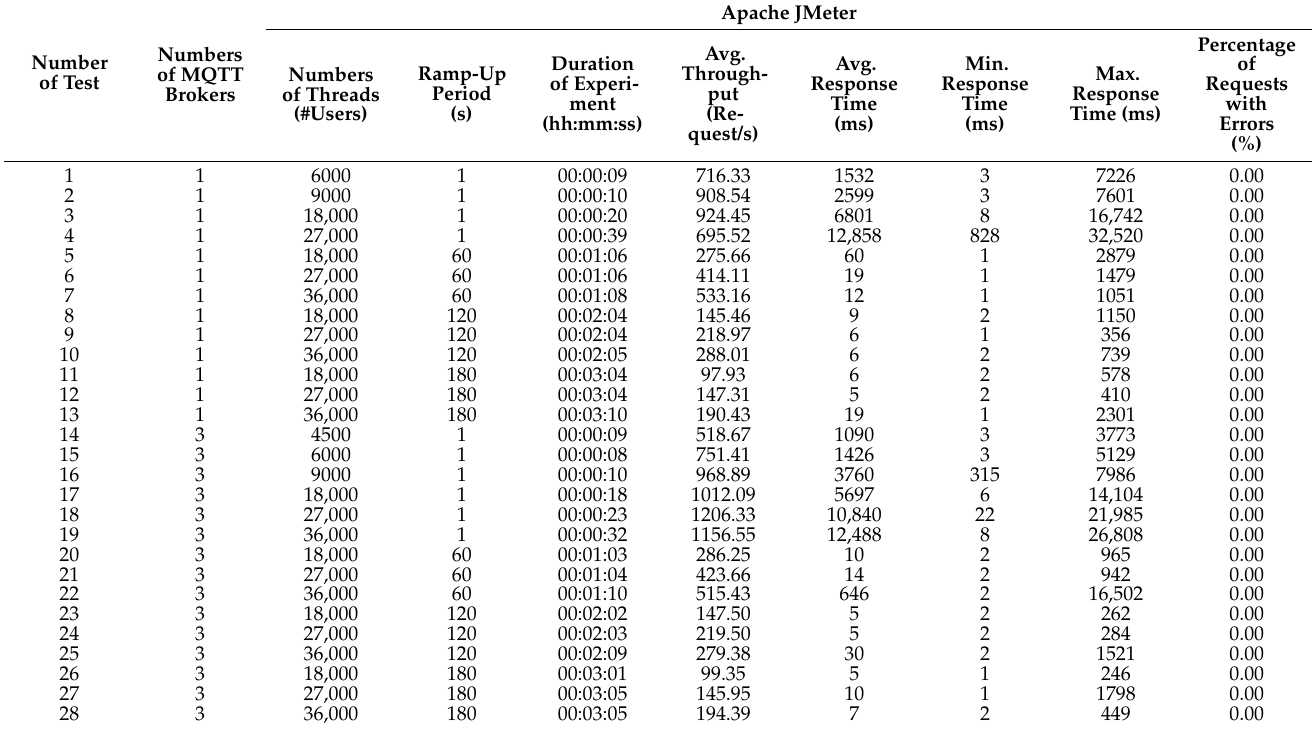
Table 4. Information on the experiments with the EMQ cluster using 1 and 3